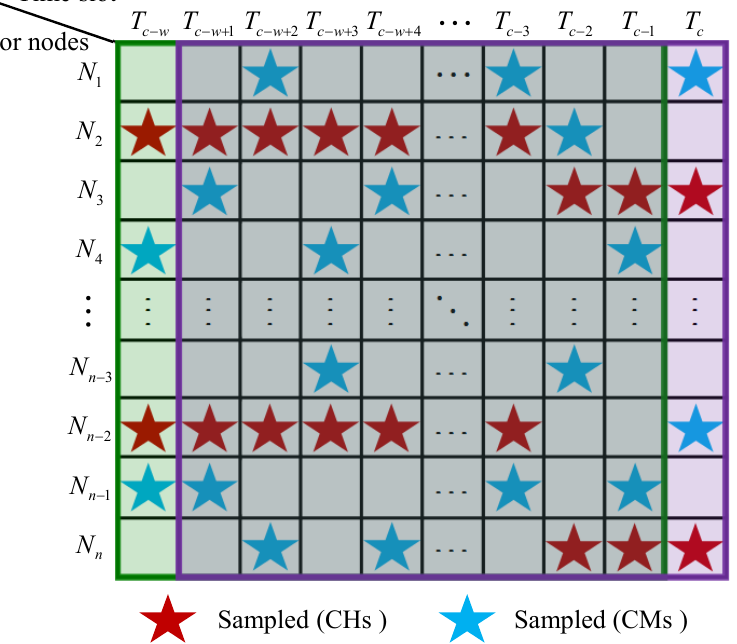
Figure 2. Sampled data using sliding window